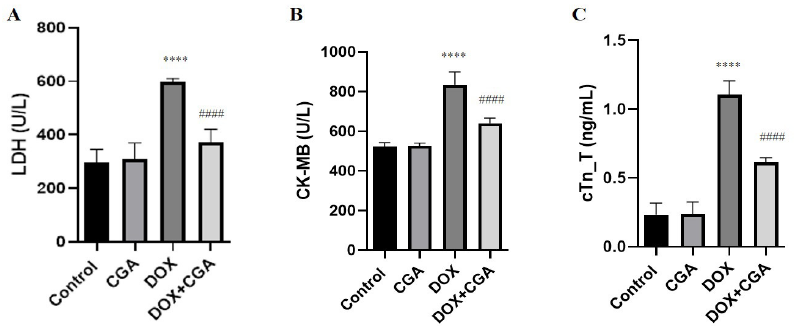
Figure 2. Serum cardiac damage marker levels. The serum levels of ( A ) LDH, ( B ) CK-MB, and ( C ) cTn-T were markedly decreased with CGA treatment. Data are presented as the means ± SD. **** p < 0.0001 vs. the control group, #### p < 0.0001 vs. the DOX group (n = 7). CGA: Chlorogenic acid (100 mg/kg); DOX: Doxorubicin (15 mg/kg).